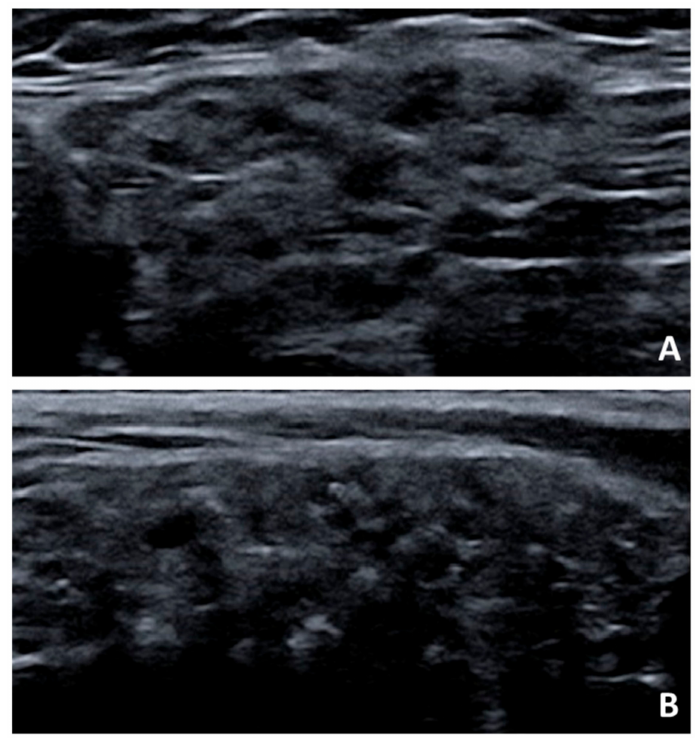
Figure 4. Salivary gland ultrasonography findings in pSS. Presence of hypoechogenic areas and hyperechogenic reflections in the ( A ) submandibular gland and ( B ) parotid gland of a pSS